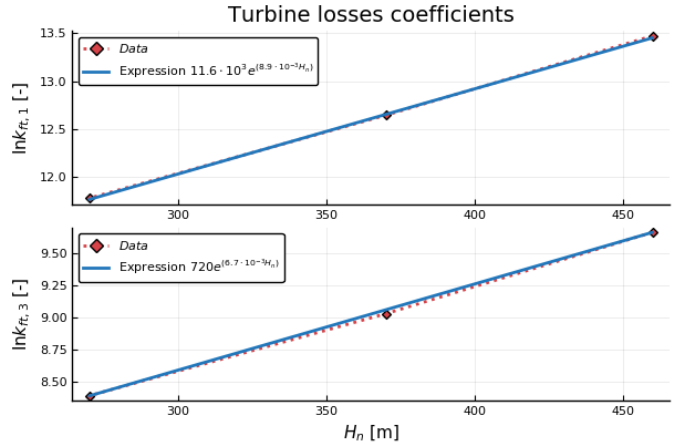
Figure 5. Linear relationship between natural logarithm of the turbine loss coefficients, k ft ,1 and k ft ,3 and the nominal